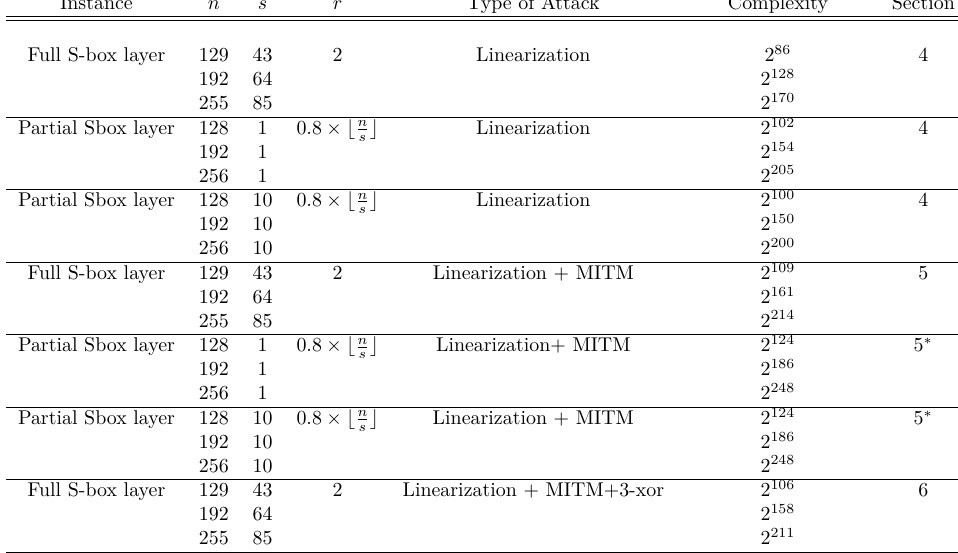
Table 1: Summary of results. Note for the Linearization+MITM (+3-xor) approaches the complexity is given in “evaluations of a quadratic expression”. For the Linearization only approach, the complexity is in “number of Gaussian eliminations.” ∗ As explained in Section 4, these are best case complexities that occur for around 29% of the LowMC